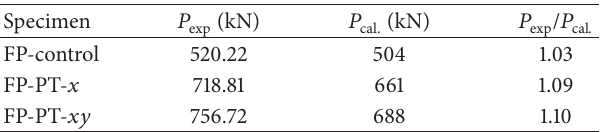
Table 4: Results of failure